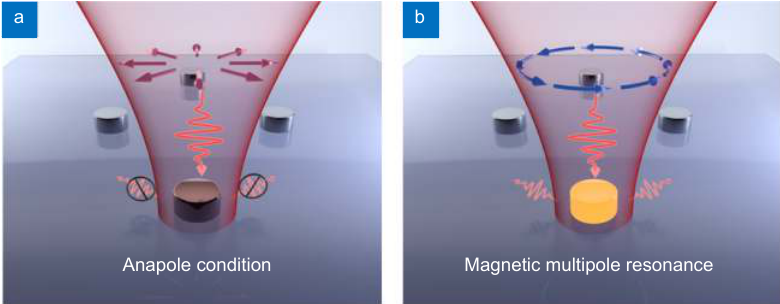
Fig. 1 | Schematic of a reconfigurable optical antenna which supports the radiationless anapole condition hidden in a magnetic reson- ances at the same frequency. Tightly focused RP ( a ) or AP ( b ) beam is used to selectively realize the nonscattering and resonant scattering scenarios of the optical